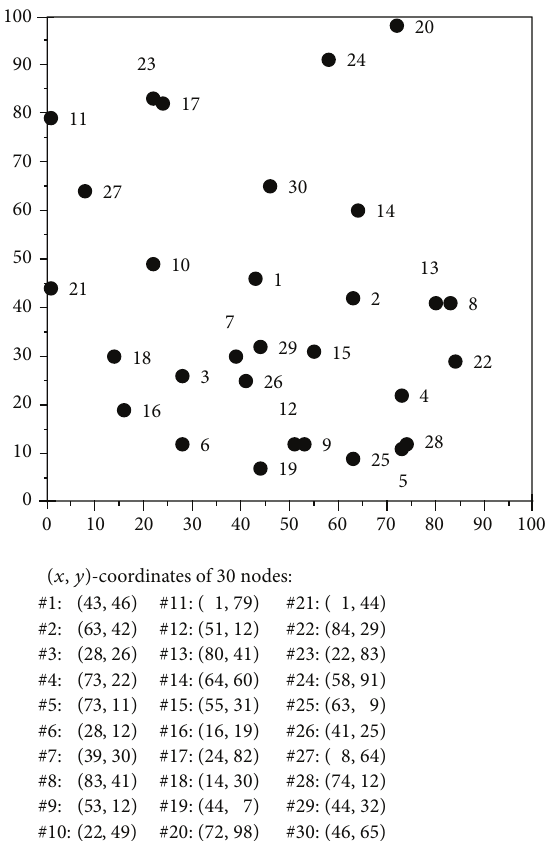
Figure 10: The locations of the 30 nodes in a network.